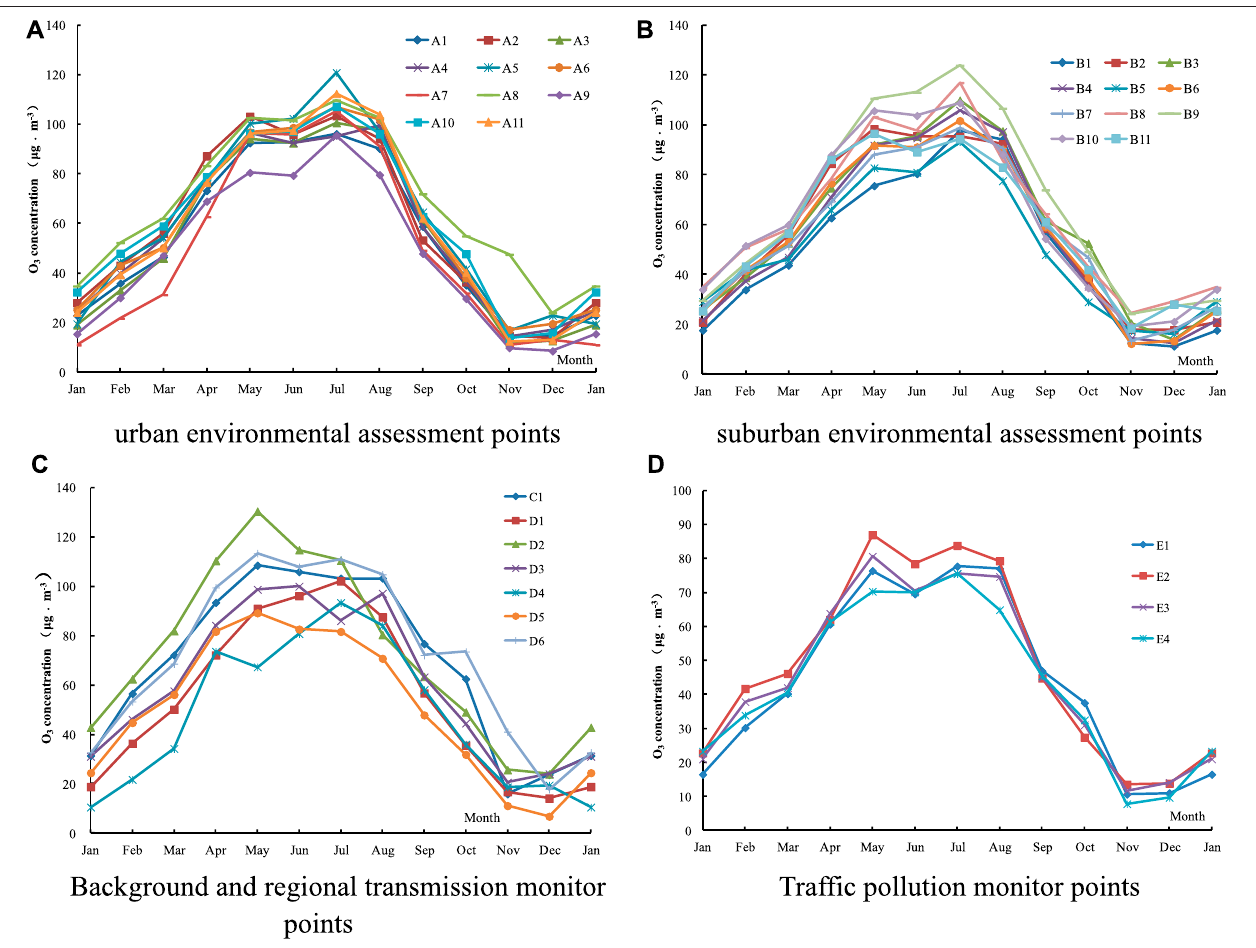
FIGURE6 | Monthly averaged O 3 concentrations at (A) urban environmental assessmentpoints, (B) suburban environmental assessmentpoints, (C) background and regional transmission monitor points, and (D) traf fi c pollution monitor points in 2015.